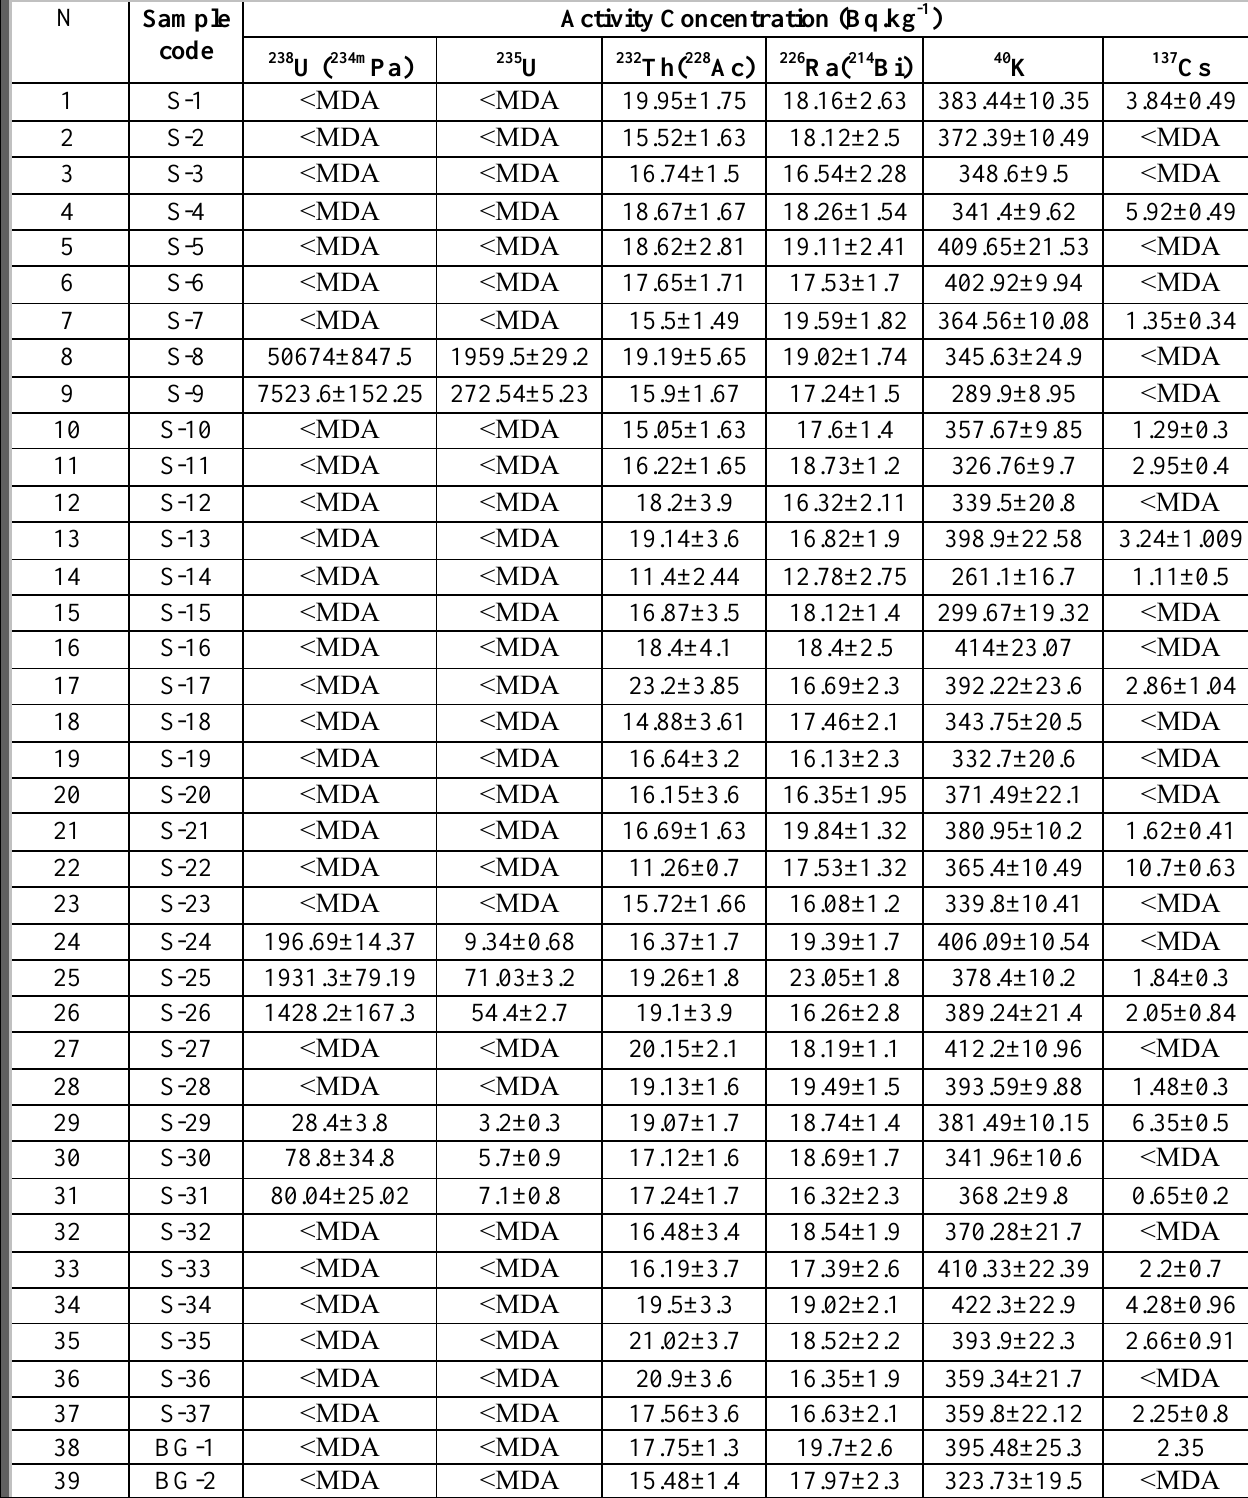
Table1: The measurements of radionuclides activity in the soil